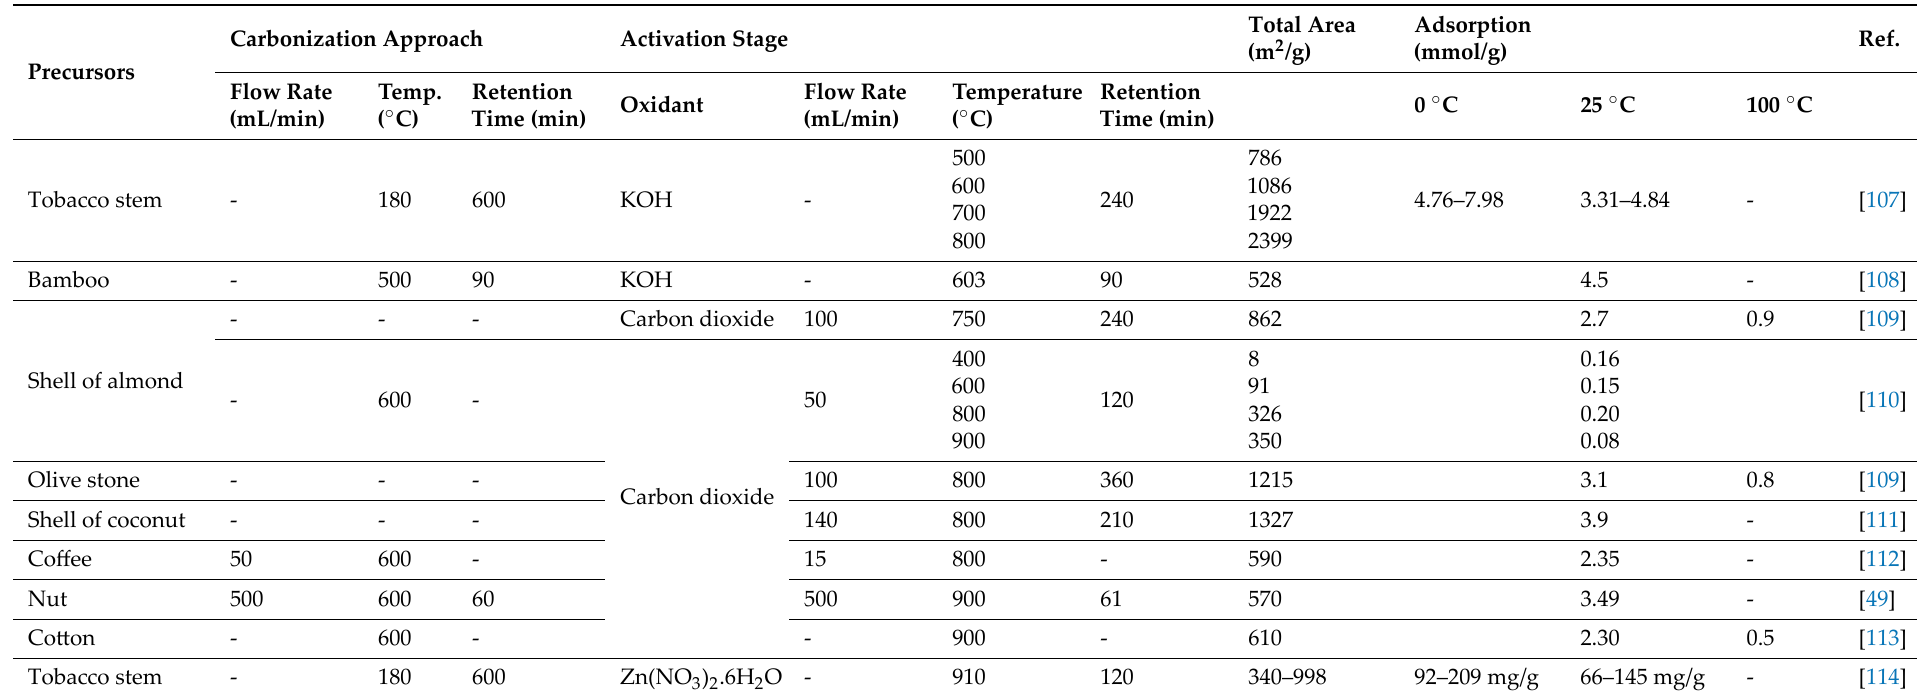
Table 3. Investigations on activated carbon produced purposely for carbon dioxide purification under atmospheric